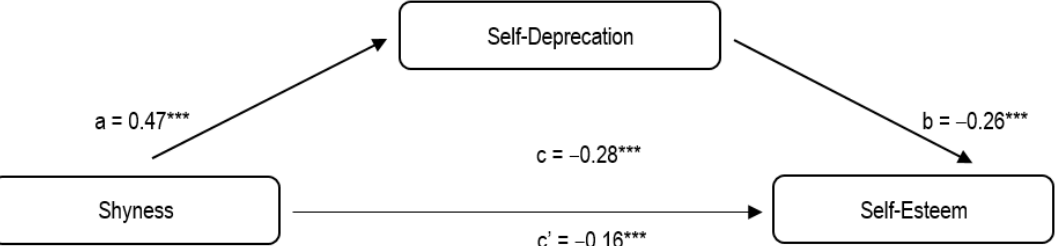
Figure 2. Results of mediation analysis of self-deprecation in the relationship between shyness and self-esteem. *** p < 0.001 .